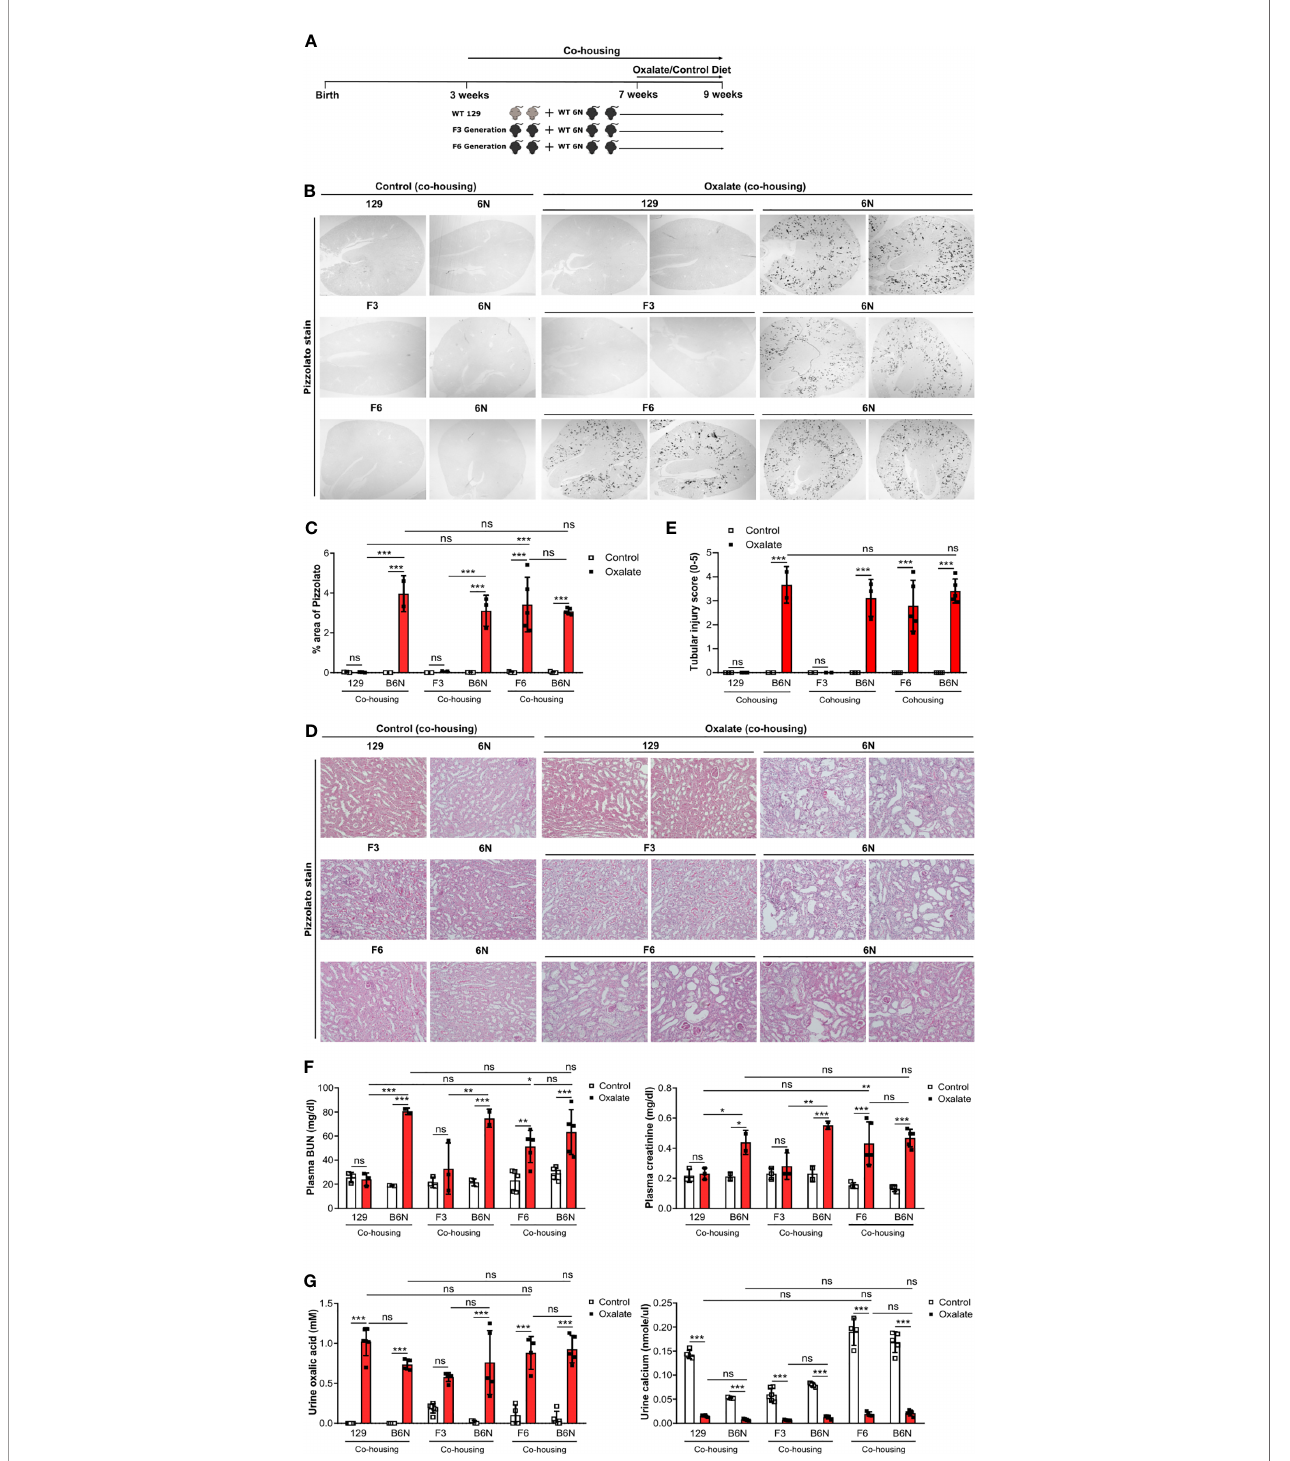
FIGURE 6 | Co-housing does not in fl uence CaOx crystal deposition in 129 mice on a B6N background. (A) Schematic diagram of experiment setup. Three week- old B6N mice were co-housed either with 129 mice or B6N/129 F3 and F6 mice for 4 weeks, and then placed on a control diet or oxalate-rich diet for 14 days. (B, C) Pizzolato staining to identify CaOx crystal deposits in kidney sections (B) and quanti fi cation of % area (C) . Original magni fi cation ×25. (D, E) PAS stain illustrates tubular injury (D) with quanti fi cation (E) . Original magni fi cation x200. (F) Plasma BUN and creatinine levels were measured by colorimetric assays. (G) Urinary concentrations of oxalic acid and calcium. Data are mean ± SD from 2 to 5 mice per group. *p < 0.05; **p < 0.01; ***p < 0.001; ns, not signi fi